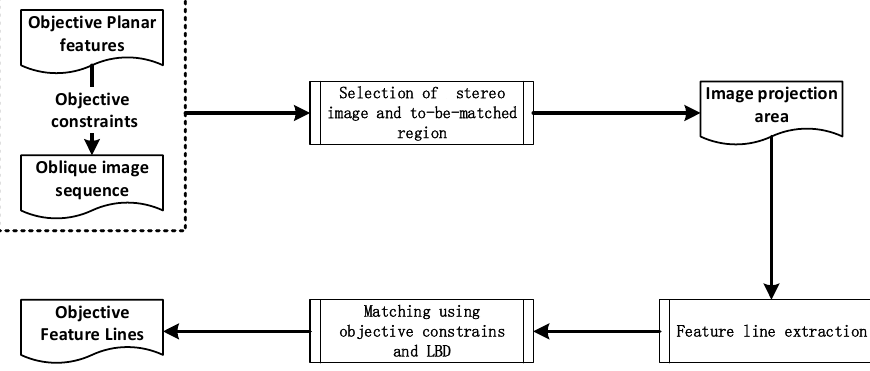
Figure 5. Feature line extraction and matching from oblique multi-view images.